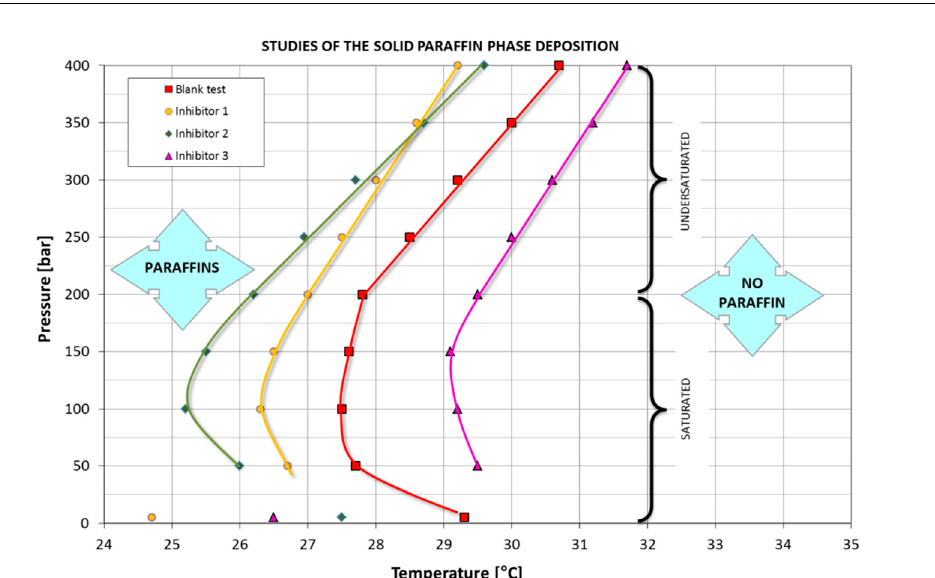
Figure 4. Pressure–temperature chart of para ffi n precipitation—determined experimentally for crude oil sample.